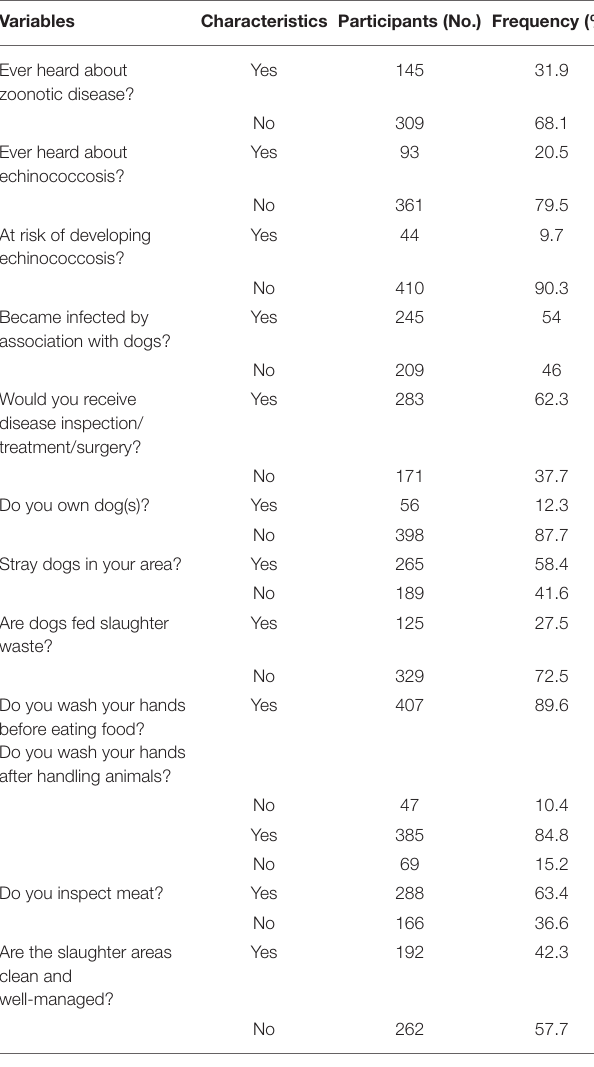
TABLE 2 | Knowledge, attitude, and practices (KAPs) toward CE among the study respondents. Variables